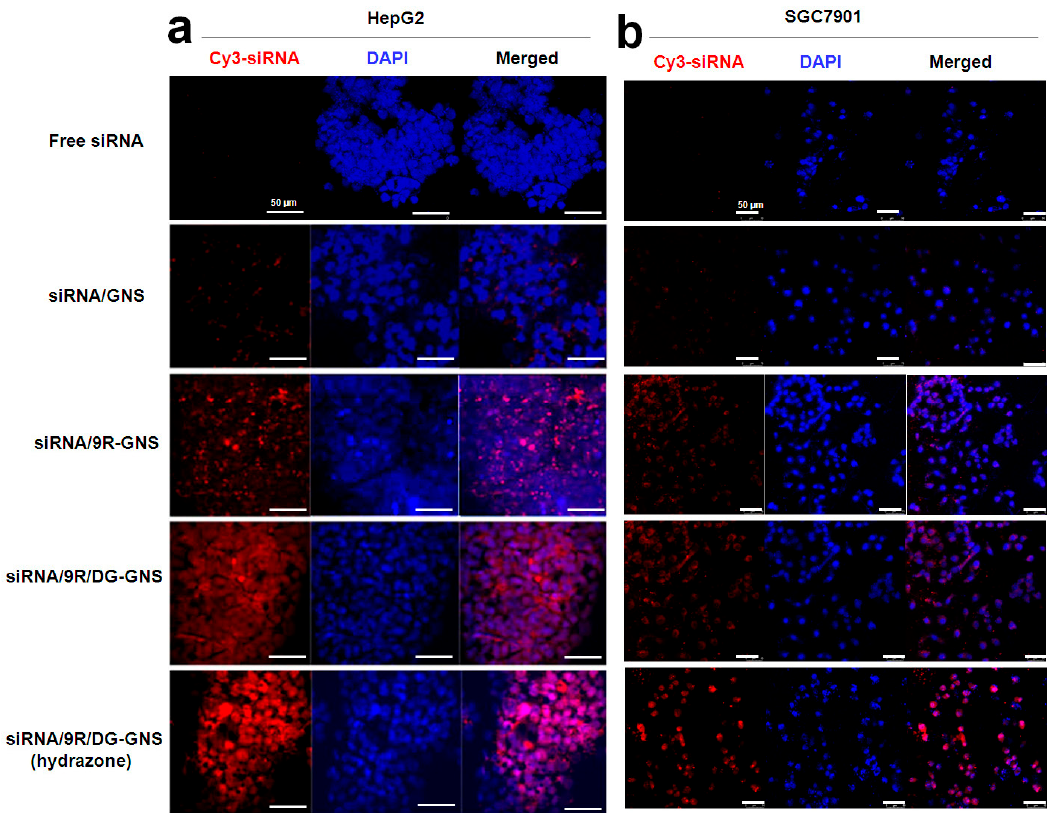
Figure 5. In vitro HepG2 ( a ) and SGC 7901 ( b ) cells uptake of the siRNA and GNS complex (siRNA/GNS, siRNA/9R/DG-GNS, and siRNA/9R/DG-GNS (hydrazone)) observed with laser confocal microscopy after incubation for 2 h. Scale bar: 50 μ m. The red color is the fluorescence of Cy3-siRNA, and blue color is 4 ′ ,6-Diamidino-2-Phenylindole (DAPI).